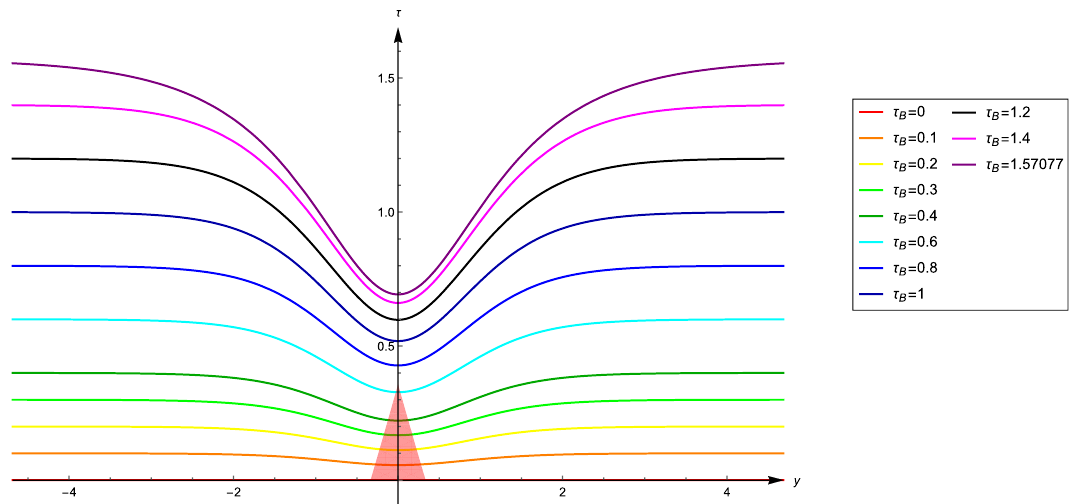
Figure 10 . Plot of the numerical solutions τ = τ ( y ) for different values of the boundary time τ B . The configuration is taken to be symmetric, i.e., τ L = τ R = τ B and the solutions have a turning point at y = 0 , which corresponds to τ All the extremal slices are computed by putting min . γ = 0 . 5 , r h = 2 . 0 and δ = 10 − 4 . The solution with τ B = 0 corresponds to the case studied in section 5.2. The shadow region is shown as the red triangle in the